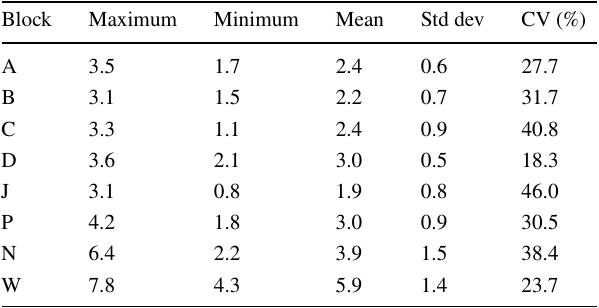
Table 1 A summary EC blocks